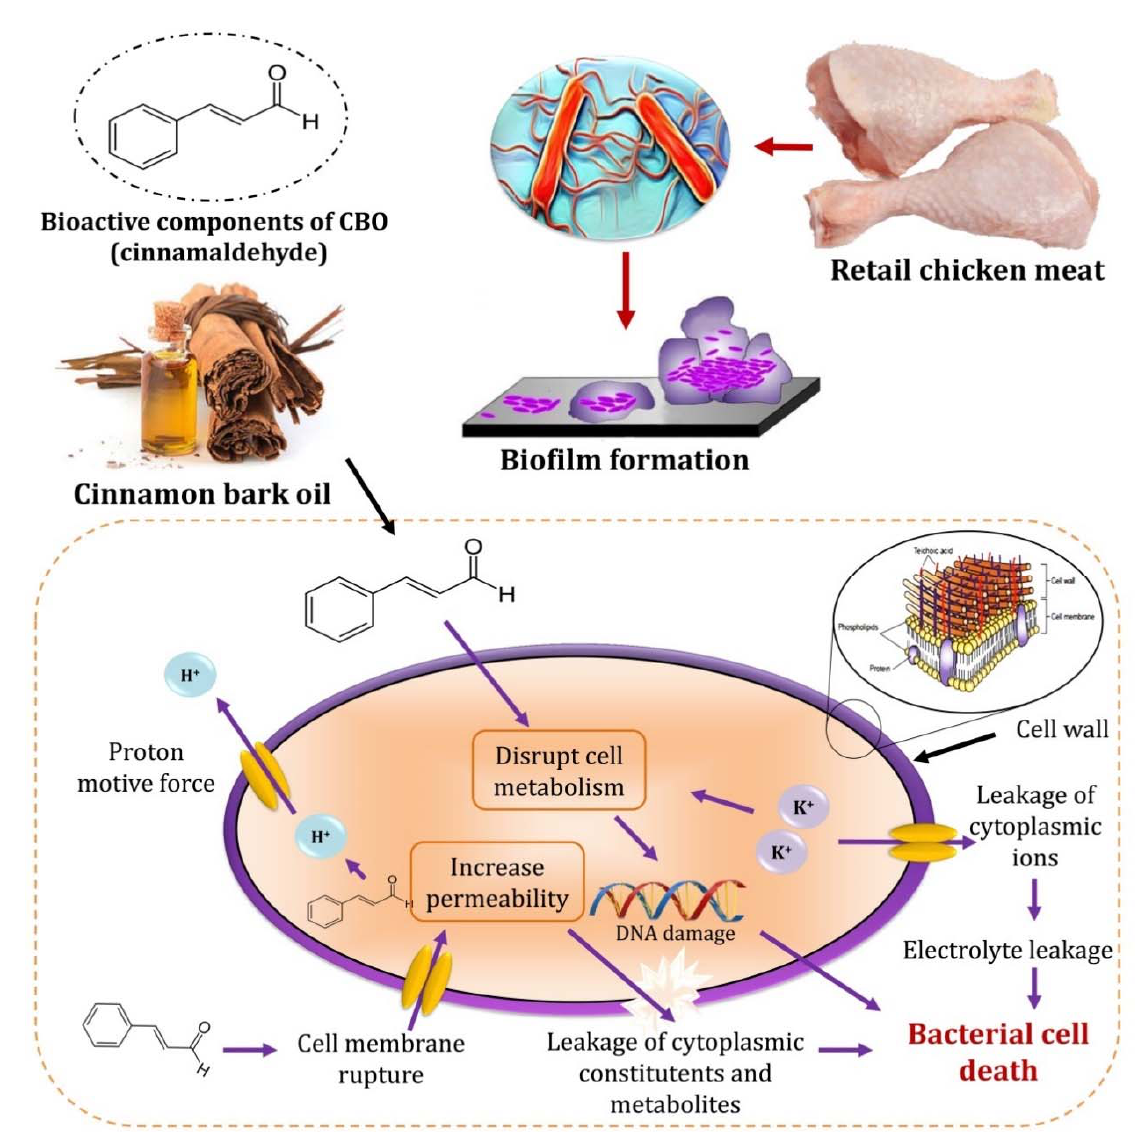
Figure 6. Proposed antibacterial mechanism of cinnamon essential oil against L. monocytogenes.